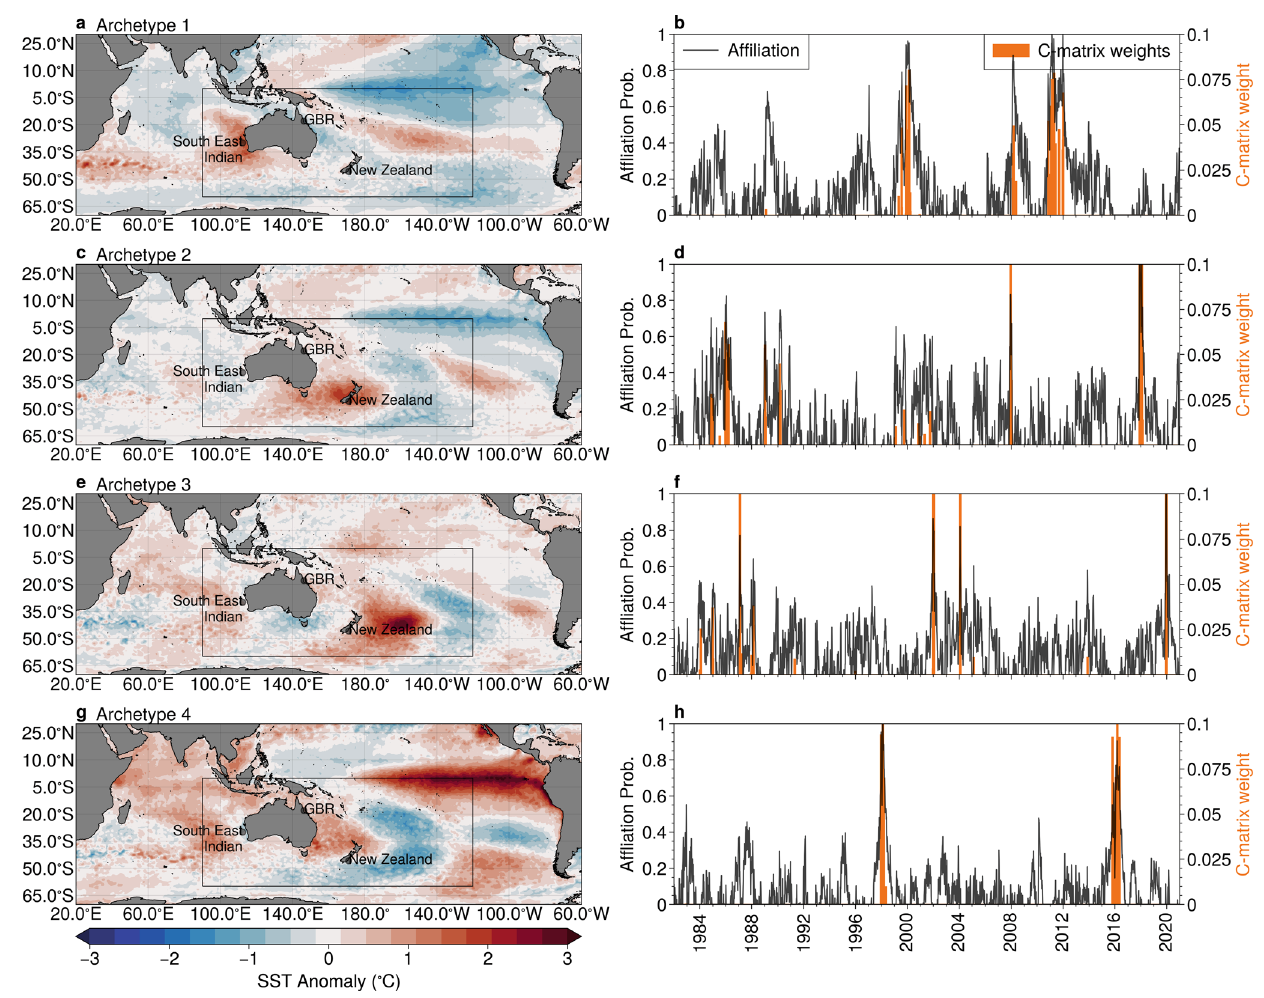
Fig. 1 | Archetypal patterns and af fi liation time series. a , c , e , g Detrended sea- surface temperature (SST) anomalies for four of the archetypal patterns computed over the Australasian region (indicated by the black box), and b , d , f , h associated af fi liation time-series (black solid line) and the weights applied to each time snapshot